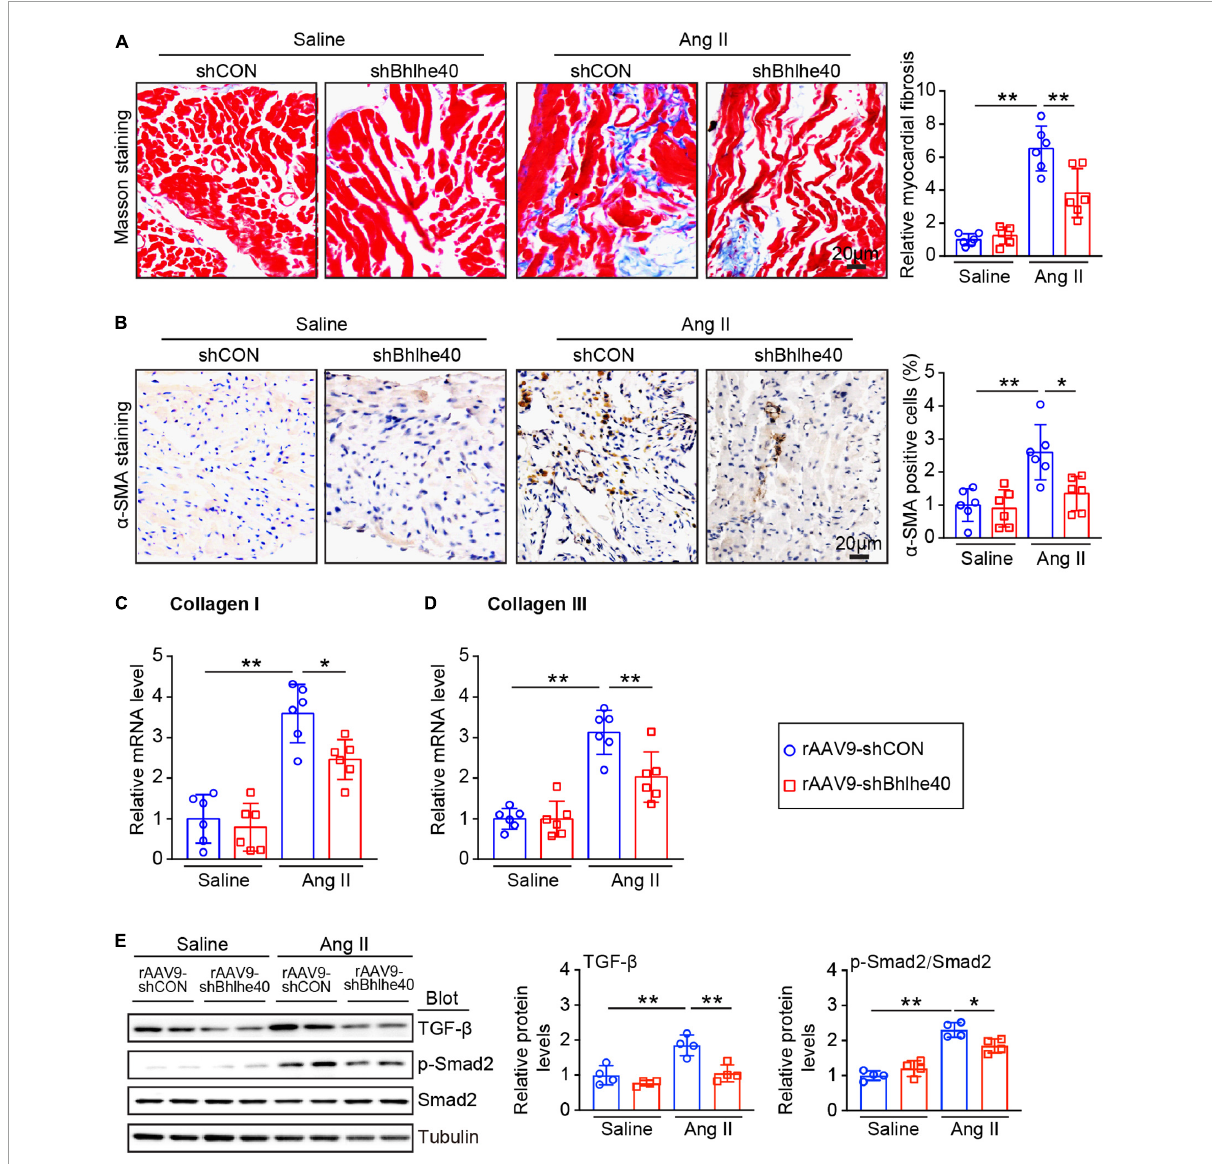
FIGURE4 Knockdown of Bhlhe40 by rAAV9-shBhlhe40 injection inhibits Ang II-induced atrial fibrosis. (A) Representative Masson staining for fibrosis that stained in blue (left) and quantification of the fibrotic area of the Masson-stained sections from the rAAV9-shCON-treated/rAAV9-shBhlhe40- treated and Ang II-infused/saline-infused hearts (right; n = 6 mice per group). (B) Representative IHC and quantification of α -SMA-positive cells (right; n = 6 mice per group). (C,D) qPCR analyses of collagen I and collagen III mRNA levels in Ang II-induced atrial tissues. (E) Immunoblotting analyses of TGF- β 1, p-Smad2, and Smad2 protein levels in atrial tissues (left), and the quantification of each protein (right, n = 4). n indicates the number of animals used in each group. * P < 0.05, ** P <